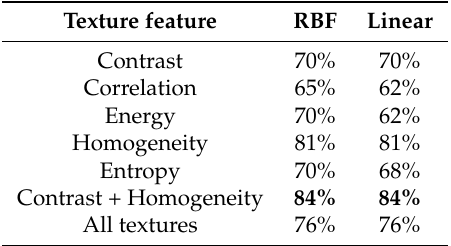
Table 2. Accuracy in classification using texture features and SVM. The columns RBF and Linear represent the accuracy when radial basis function kernel and linear kernel were used for the SVM, respectively.